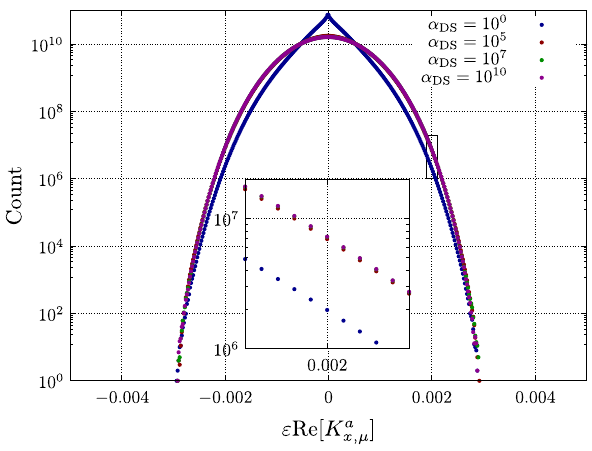
Fig. 7 Histogram of the drift added by DS for different values of the control parameter α DS